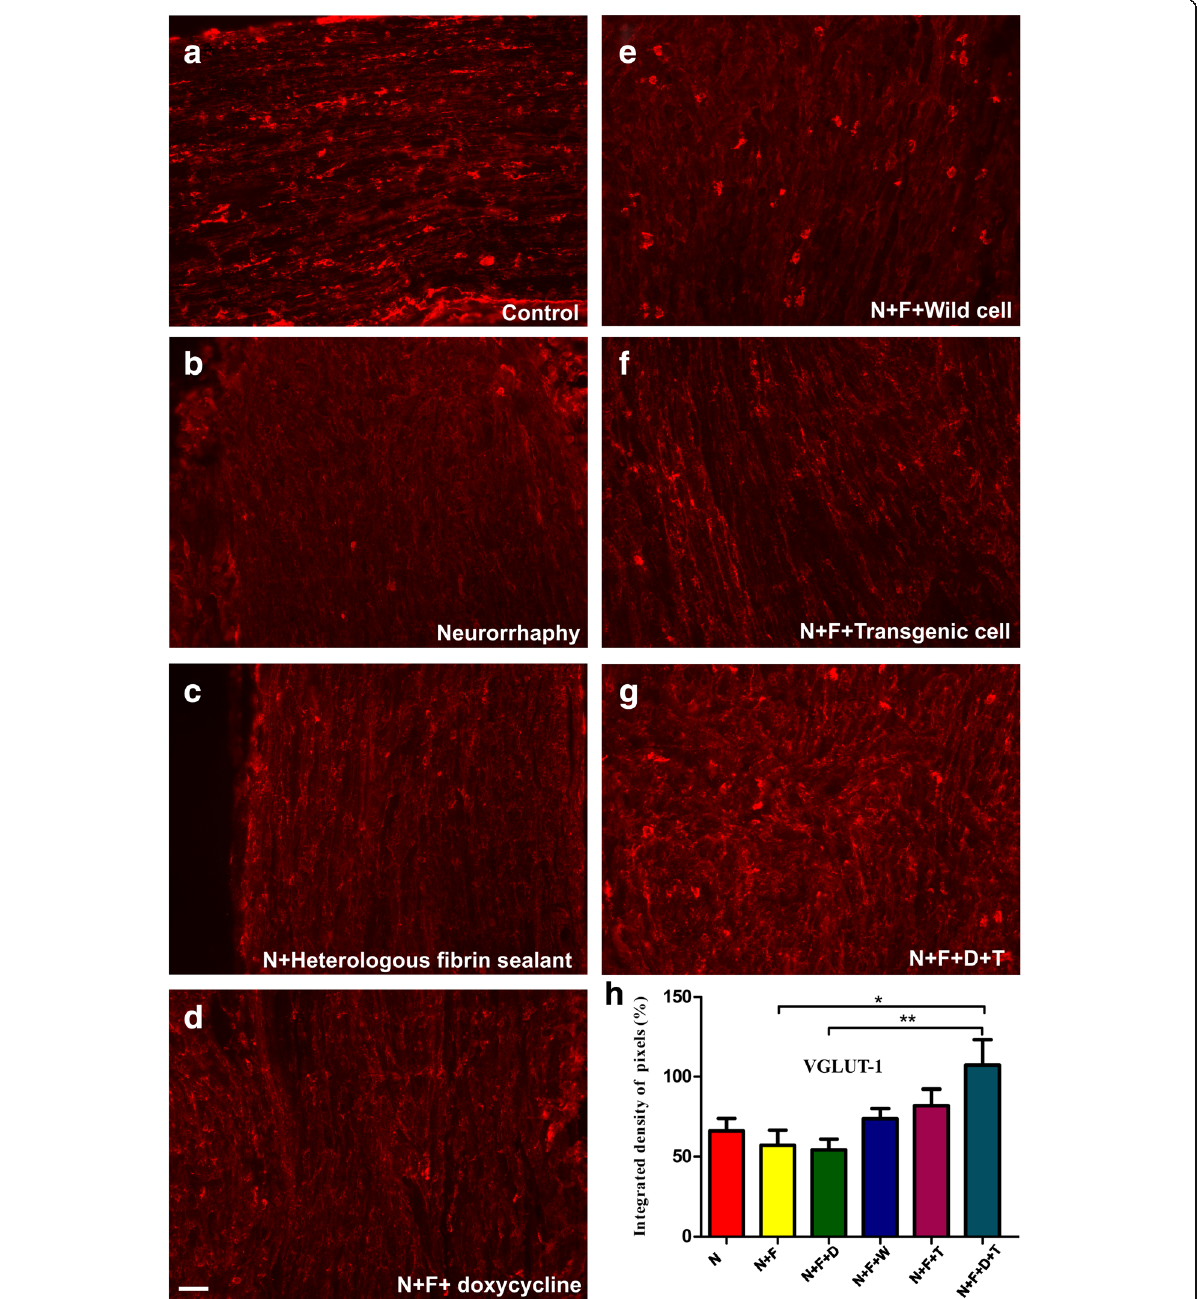
Fig. 5 Anti-VGLUT1 immuno-staining of ( a ) the control nerves and ( b to g ) all groups, 60 days after surgery. h Quantification of the integrated density of pixels in the experimental groups relative to control group (%). Statistically, the difference between N+F versus N+F+D +T and N+F+D versus N+F+D+T groups are meaningful with p <0.05 and p <0.01, respectively. Scale bar: 50 μ m. N: neurorrhaphy, F: heterologous fibrin sealant, D: doxycycline, T: transgenic